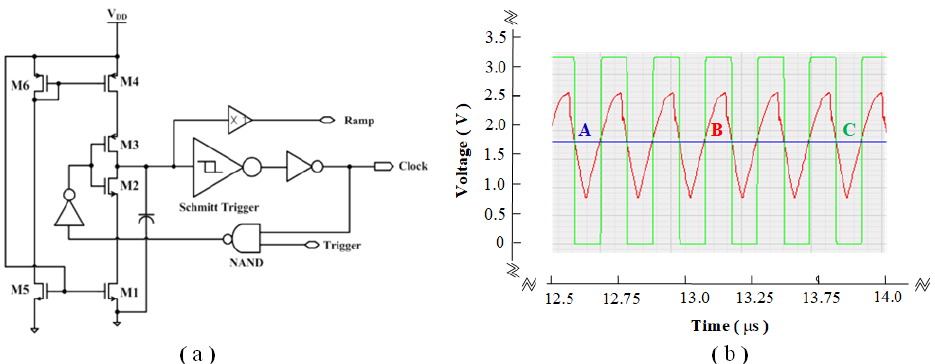
Figure 5. Proposed oscillator circuit: ( a ) oscillator circuit; ( b ) output of compensator (A), oscillator (B), and comparator (C).